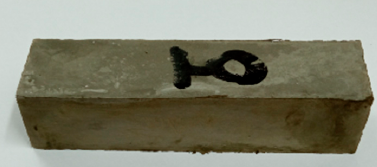
Figure 7. Beam used in flexural strength test (photo by K. Se ń czuk).